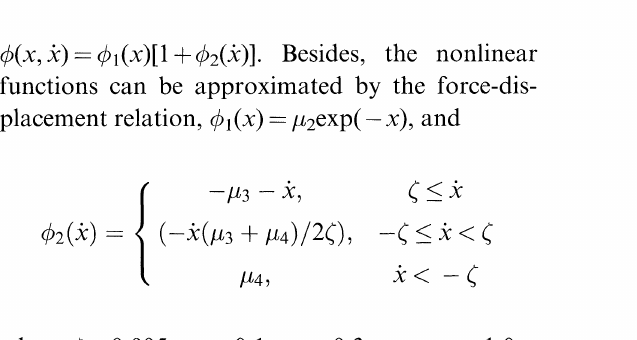
FIGURE 2 Performance of the discrete-time unveiling scheme. The force acting onto the Duffing equation is unveiled.